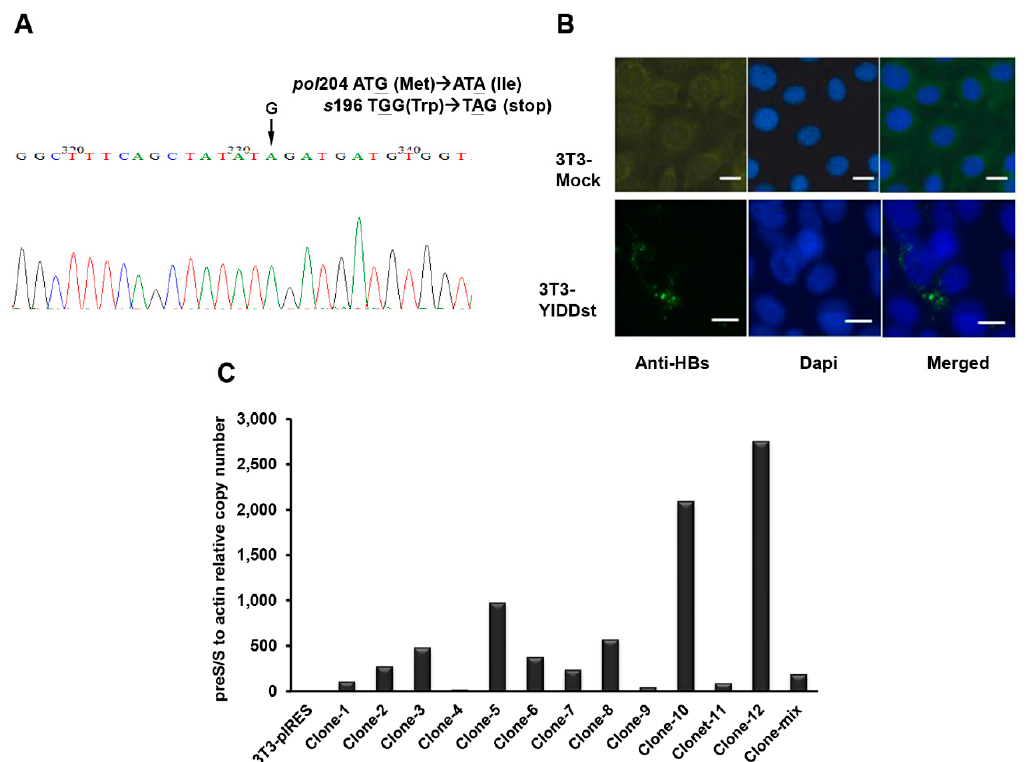
Figure 1. Plasmid construction and cellular expression of the rtM204I/sW196* mutant. ( A ) Sanger’s